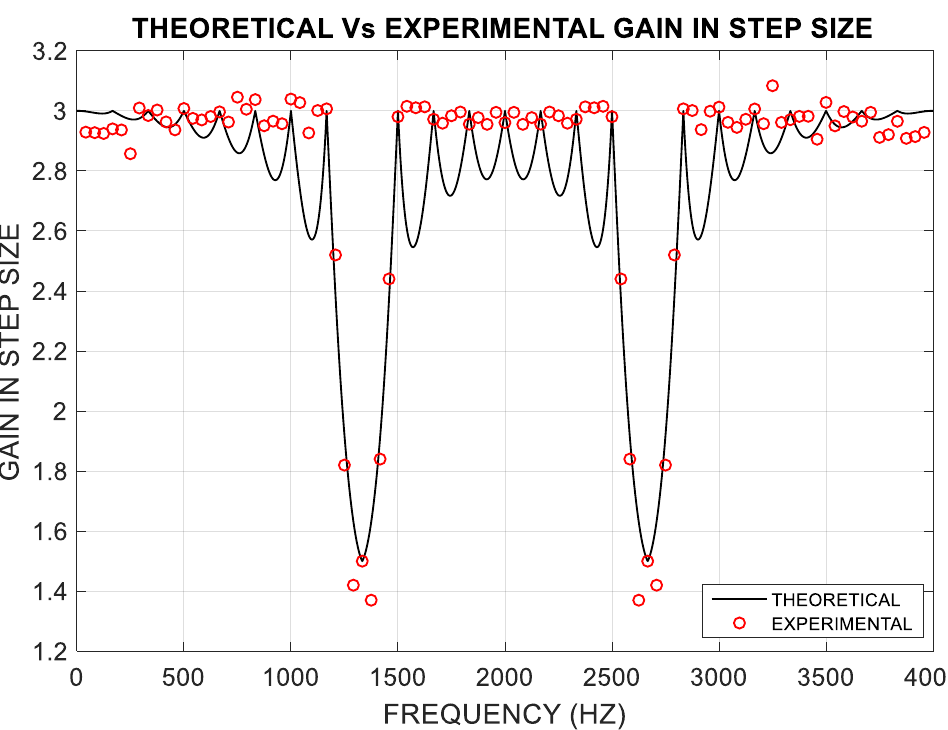
Figure 6. Theoretically predicted gain in step-size vs. simulation results of the G μ —Mod Fx H Seq LMS algorithm in a modelled ANC system.